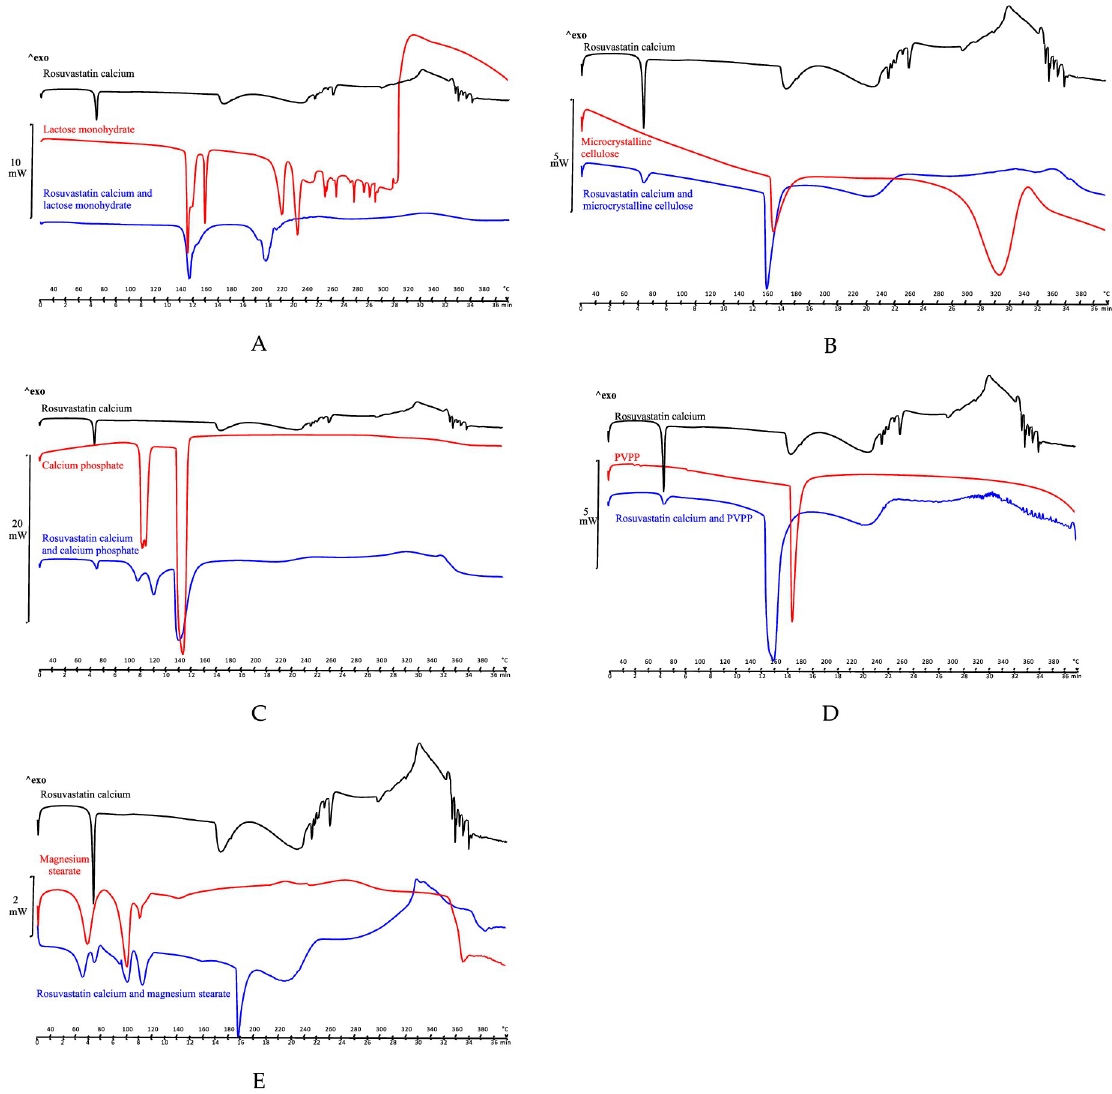
Fig 6. DSC binary (1:1) mixtures of rosuvastatin and excipients. (A) DSC of rosuvastatin, lactose monohydrate and physical mixture. (B) DSC of rosuvastatin, cellulose microcrystalline and physical mixture. (C) DSC of rosuvastatin, calcium phosphate and physical mixture. (D) DSC of rosuvastatin, PVPP and physical mixture. (E) DSC of rosuvastatin, magnesium stearate and physical mixture.